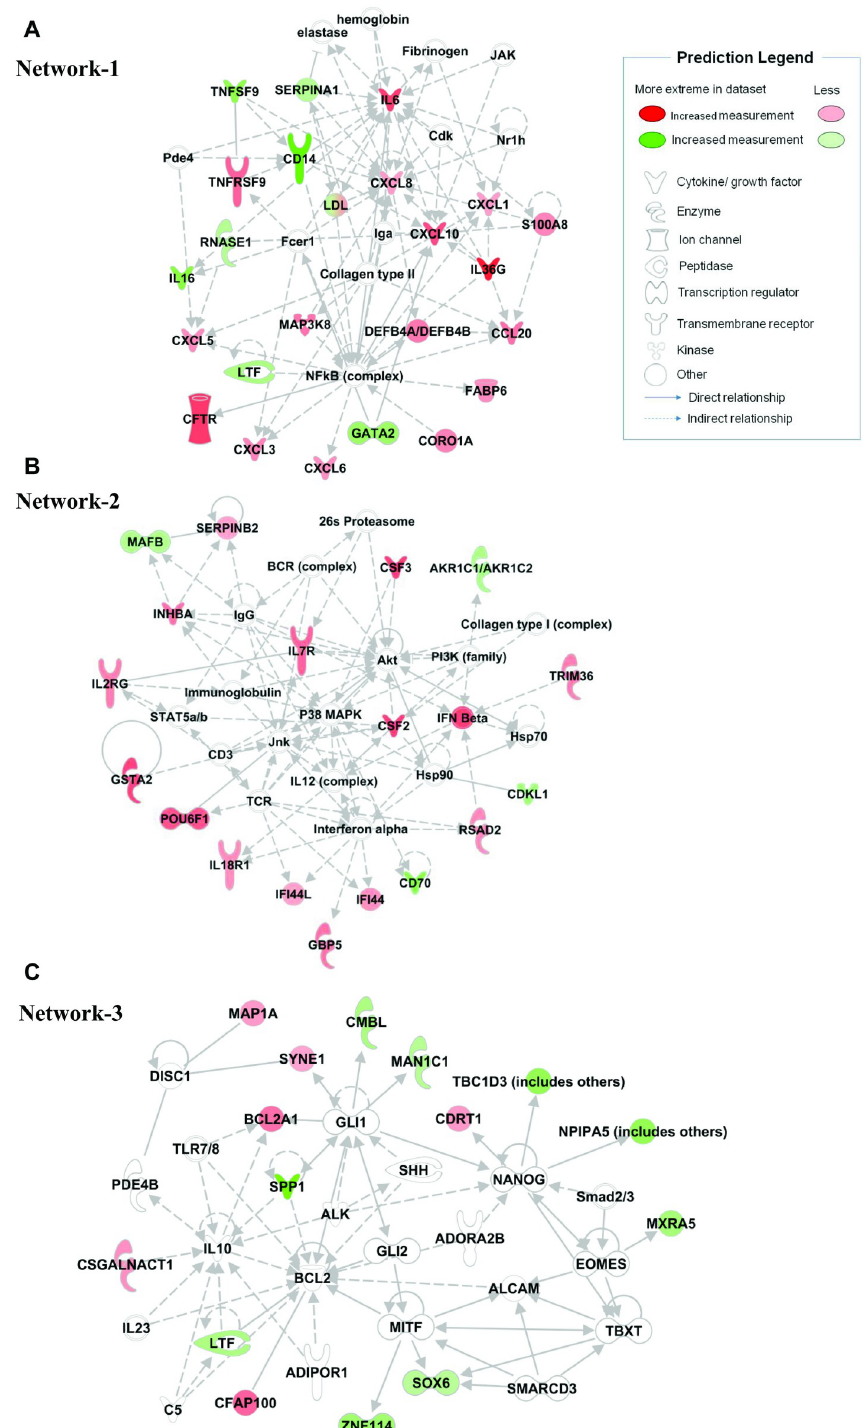
Fig 3. Generated molecular network based on differential expression of genes of SARS-CoV-2 infected ( in vitro ) airway epithelium associated with (A) ’cellular movement, hematological system development and function, immune cell trafficking’, (B) ’cellular development, cellular growth and proliferation, embryonic development’, and (C) ’cell death and survival, cell morphology, organismal development’ using ingenuity knowledge database. Coloring is based on the expression values of the genes, down-regulation in green and, up-regulation in red. Genes